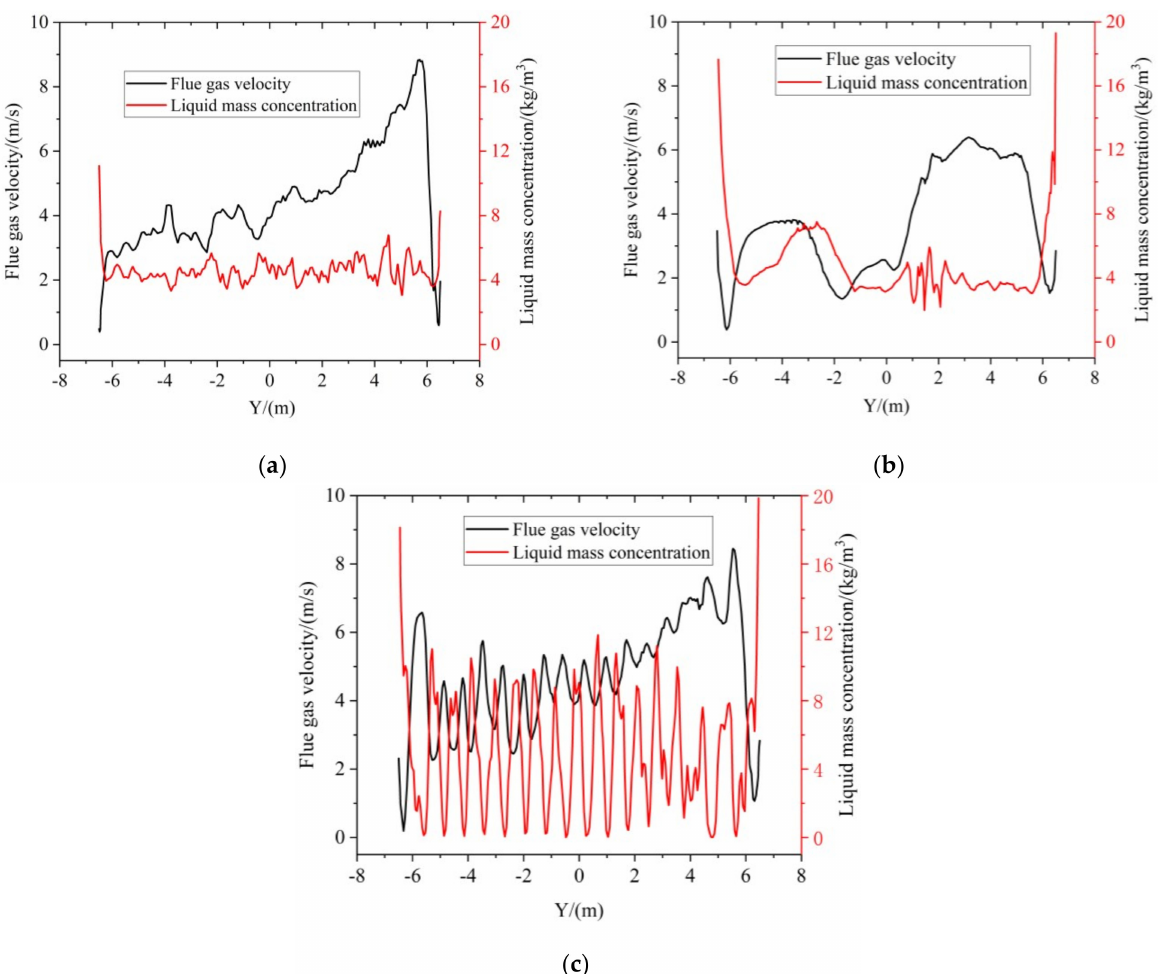
Figure 8. The distribution of flue gas velocity and liquid mass concentration on the curve of height Z = 3 m: ( a ) OST; ( b ) DST; ( c ) RBST.